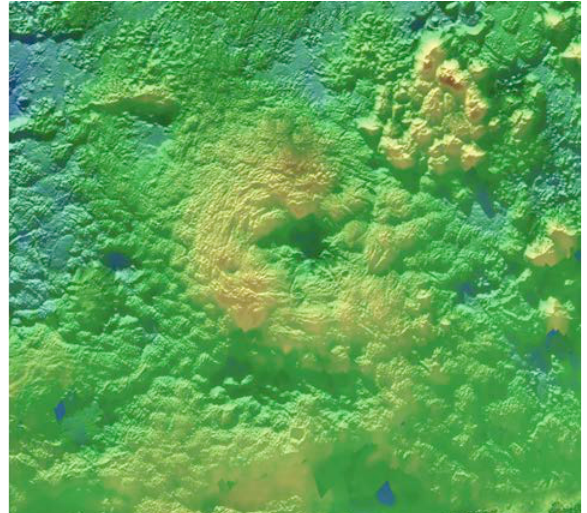
Figure 4. Color-coded topography superimposed on Pluto basemap, showing the elevated annular plateau Wright Mons. Topographic range displayed is ~4 km. Norgay Montes is the cluster of massifs to the upper right and Sputnik Planum is off image to the upper right .